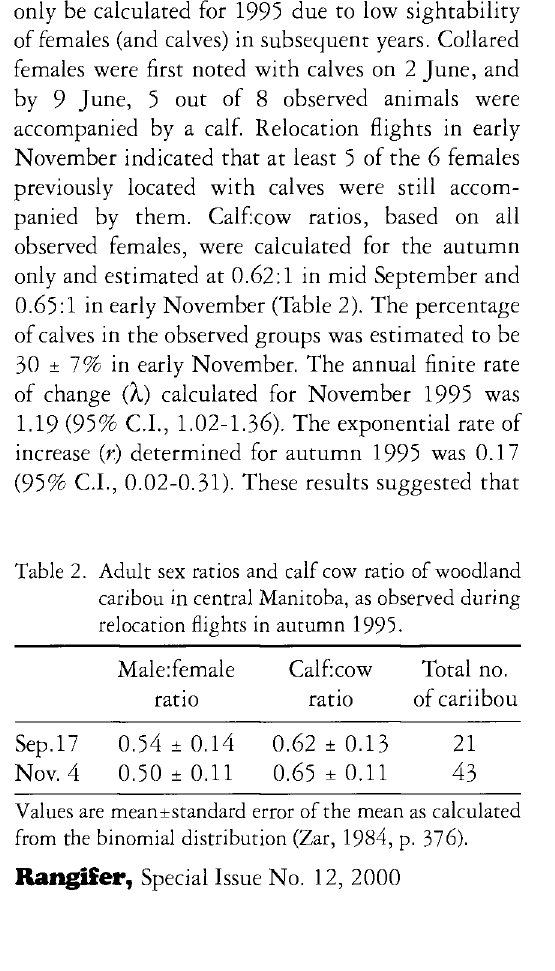
Table 2. Adult sex ratios and calf cow ratio of woodland caribou in central Manitoba, as observed during relocation flights in autumn